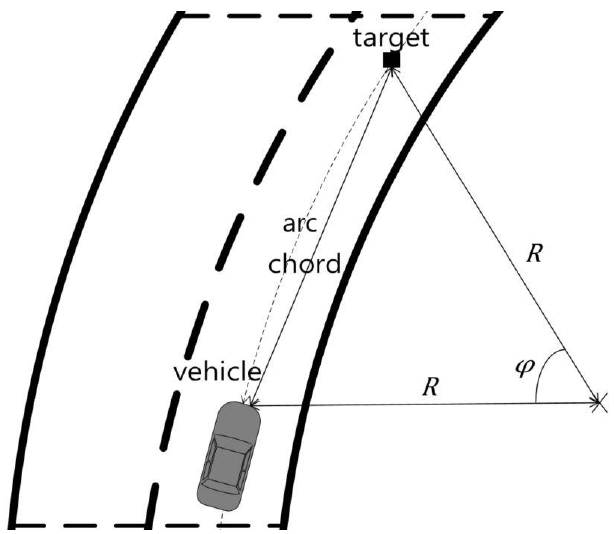
Figure 13. Distance to the object in front of the vehicle on a curved road.